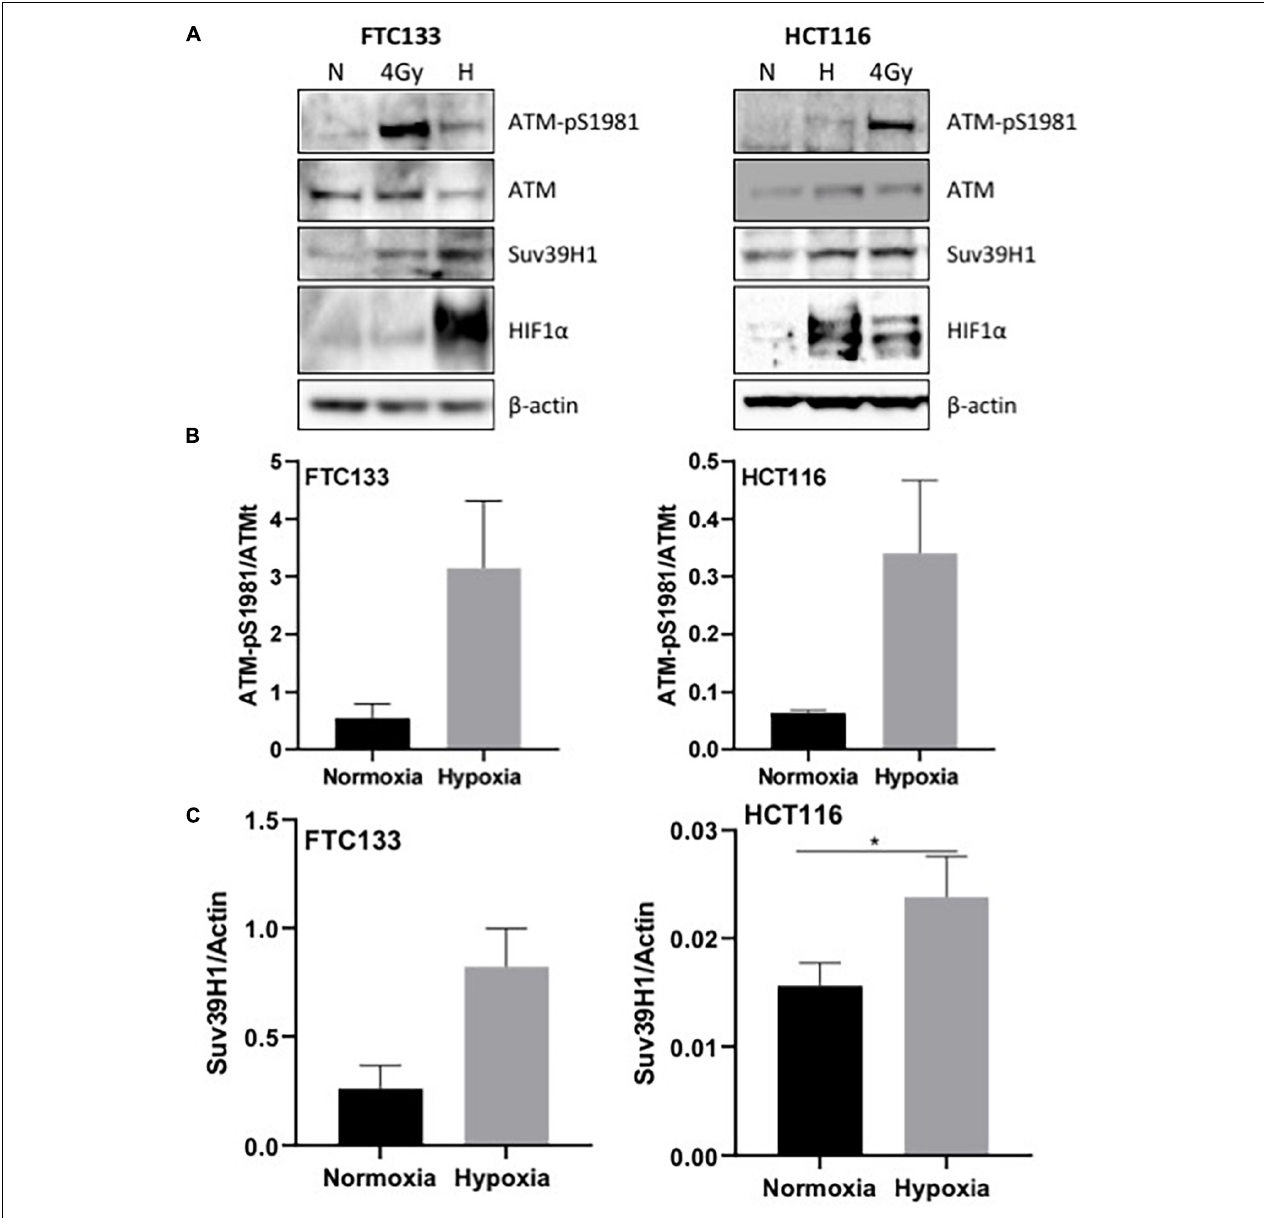
FIGURE 1 | pATM-S1981, Suv39H1 and H3K9me3 are upregulated in response to hypoxia. Cells were incubated in normoxic (N; 21% O 2 ) or hypoxic conditions (H; 0.1% O 2 ) for 18 h prior to lysis and Western blotting (A) . The graph represents the protein levels of ATM-pS1981 (B) and Suv39H1 (C) normalized to the loading control. HIF-1 α was used as a control for hypoxia and β -actin as a loading control. Three independent experiments were performed and the bar represents the mean ± SEM. * p ≤